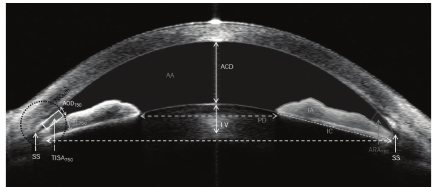
Figure 1: Anterior segment parameters determined by anterior seg- ment optical coherence tomography. Abbreviation: ACD: anterior chamber depth, SS: scleral spur, IT750: iris thickness 750 𝜇 m from thescleralspur,IA:cross-sectionalareaofiris,AA:anteriorchamber area, IC: iris curvature, LV: lens vault, AOD 750 : angle opening distance 750 𝜇 m anterior to the scleral spur, ARA 750 ,: angle recess area, triangular area formed by the AOD 750 , TISA 750 : trabecular- iris space area—trapezoidal area with the following boundaries; anteriorly, the AOD 750 and posteriorly, a line drawn from the scleral spur perpendicular to the plane of the inner sclera wall to the opposing iris; superiorly, the inner corneoscleral wall; and inferiorly, the iris surface, PD: pupillary